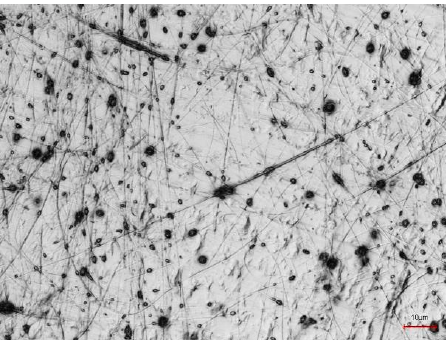
Figure 5. Aluminum surface after separating the PAN nanofiber mat electrospun on it. The scale bar indicates 10 μ m.